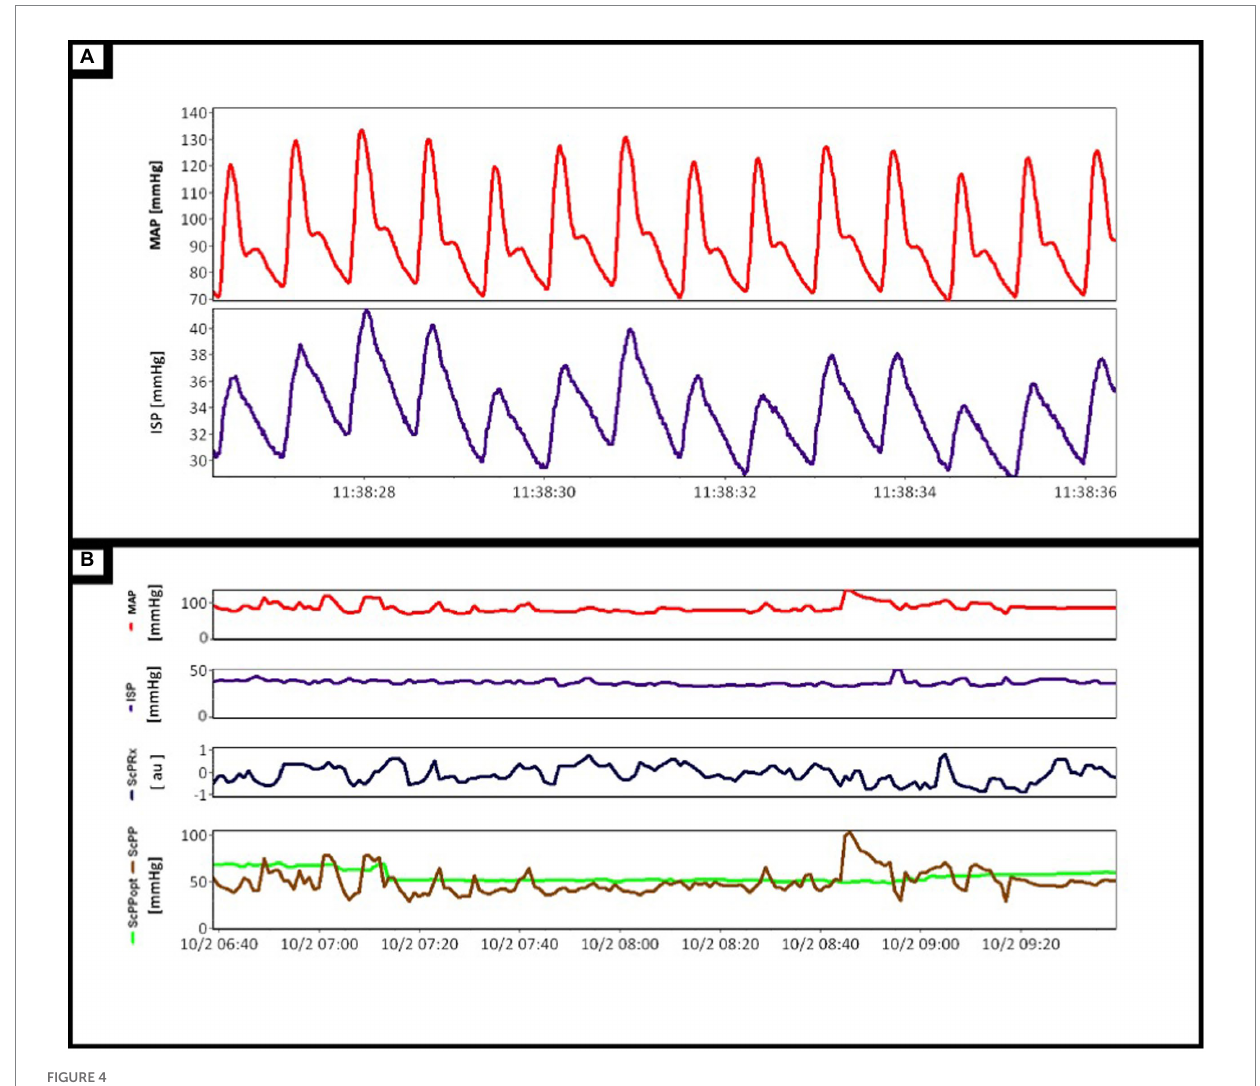
FIGURE 4 (A) Demonstrated the mean arterial pressure (MAP, red line) and intraspinal pressure (ISP, purple line) waveforms as they are recorded in real-time. (B) Displays the processed minute-to-minute physiologic data. This includes directly measured parameters such as MAP (red line) and ISP (purple line) as well as derived parameters, spinal cord pressure reactivity index (ScPRx, black line), spinal cord perfusion pressure (ScPP, brown line), and optimal spinal cord perfusion pressure (ScPPopt, green